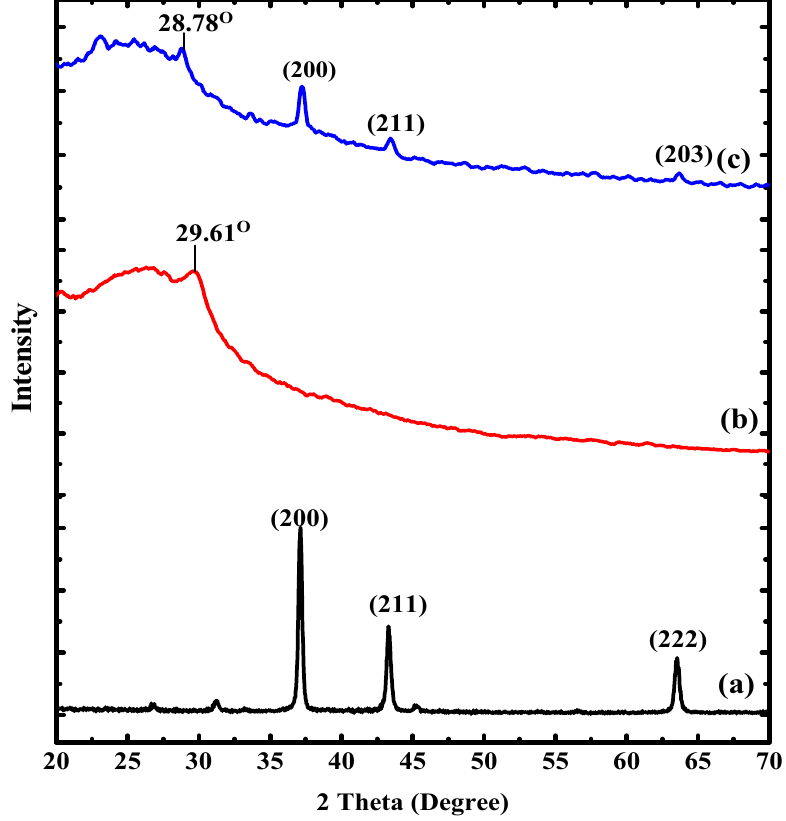
Figure 2. XRD spectra of: ( a ) Alg@Ag NPs; ( b ) poly(acrylonitrile); and ( c ) PAN-g-Alg@Ag.